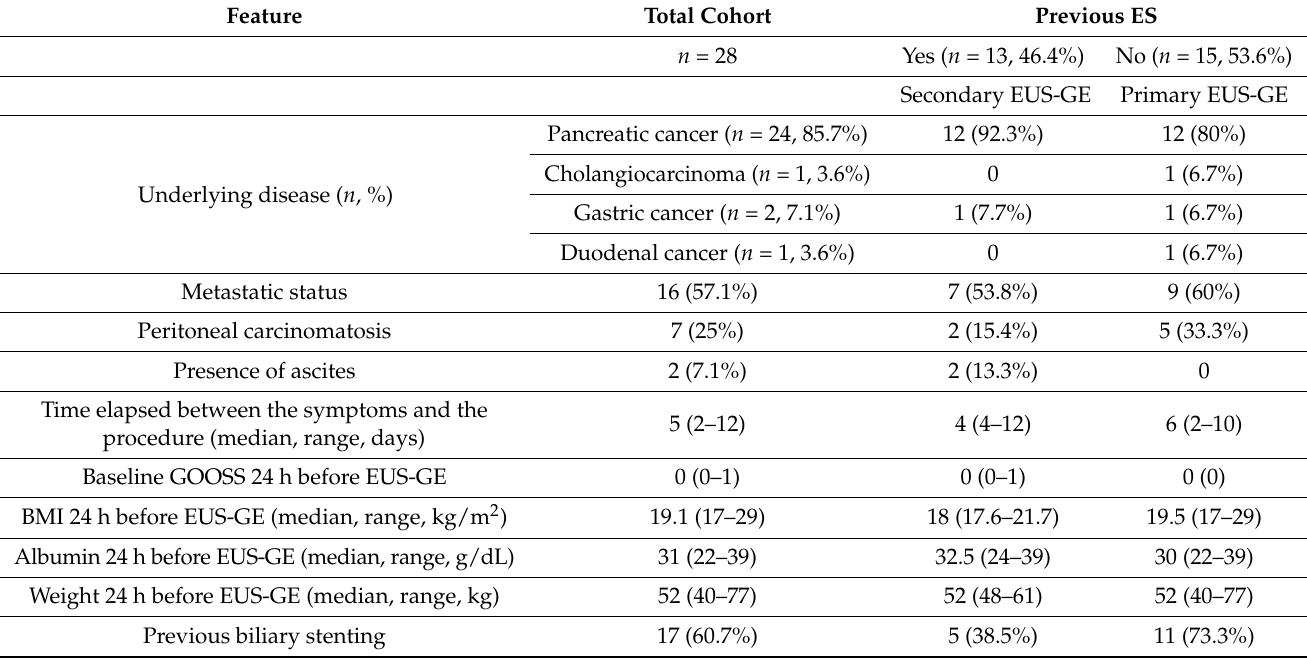
Table 1. Baseline characteristics of patients with gastric outlet obstruction who underwent an endoscopic ultrasound-guided gastroenterostomy (EUS-GE) using the freehand technique according to the presence of a previous enteral metal